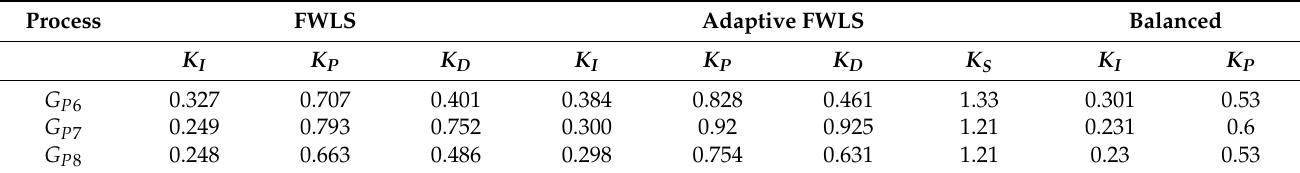
Table 4. PID controller parameters for considered